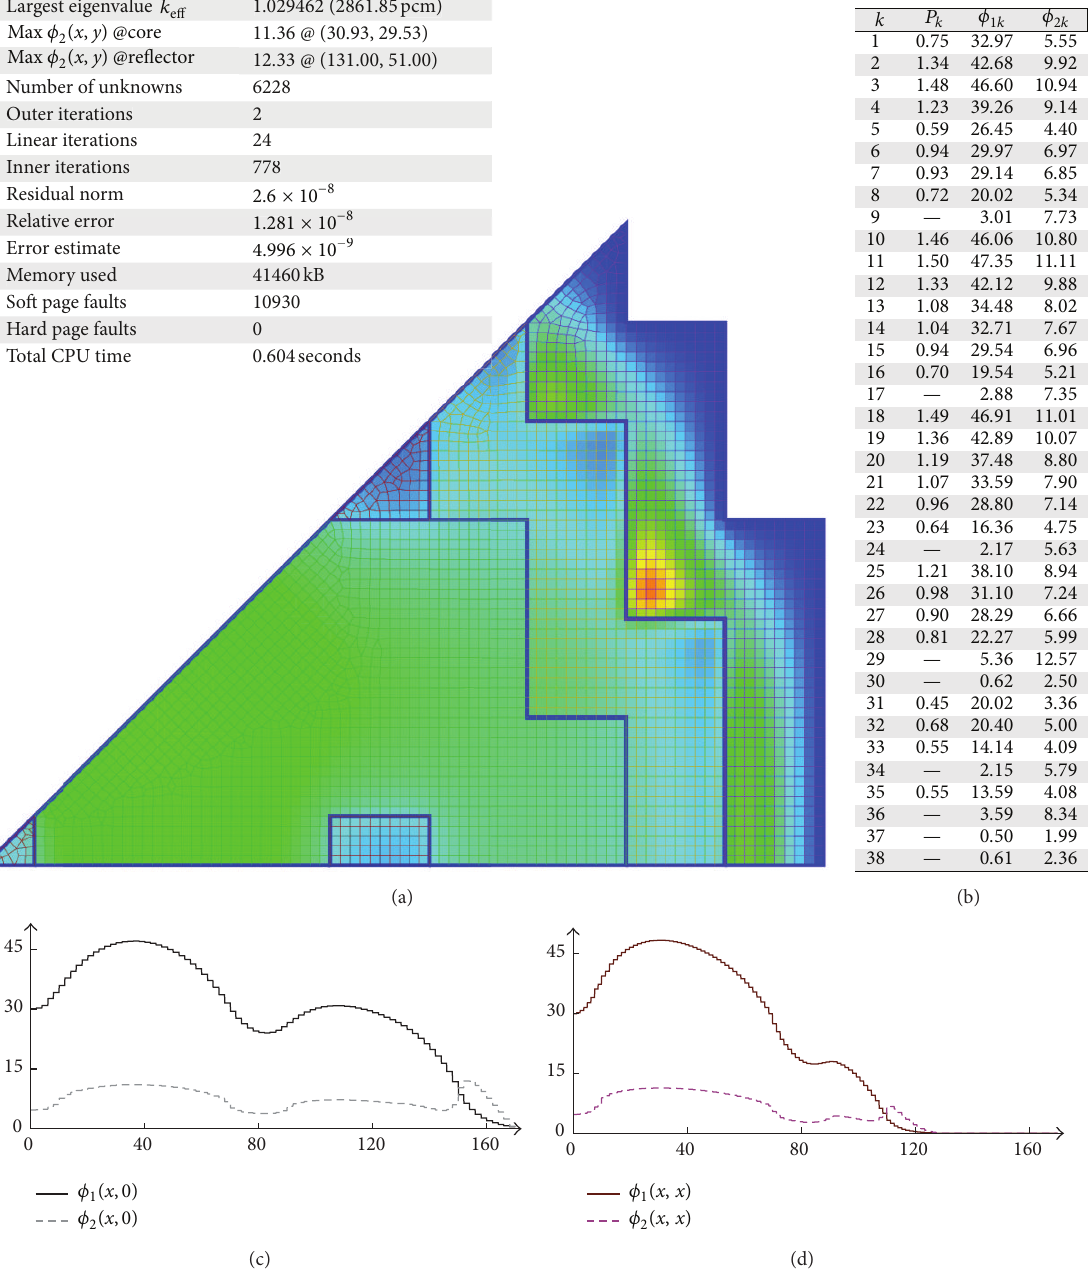
Figure 17: (a) Mesh and thermal flux distribution. (b) Power and fluxes. (c) Flux distribution 𝜙 𝑔 (𝑥, 0) along the 𝑥 -axis. (d) Flux distribution (𝑥,𝑥) along the 𝜙 𝑔